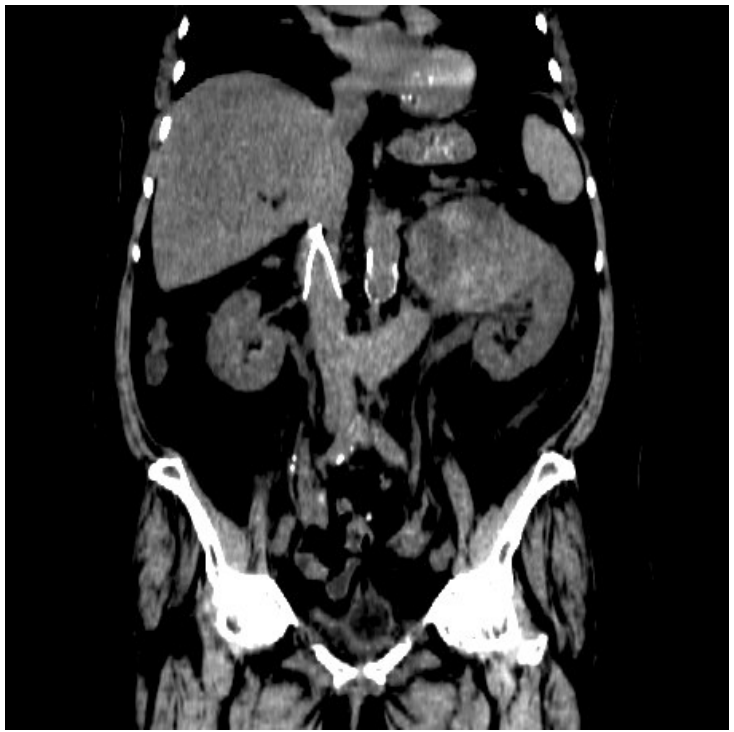
FIGURE 1 . CT with coronal reconstruction demonstrating renal vein involvement.